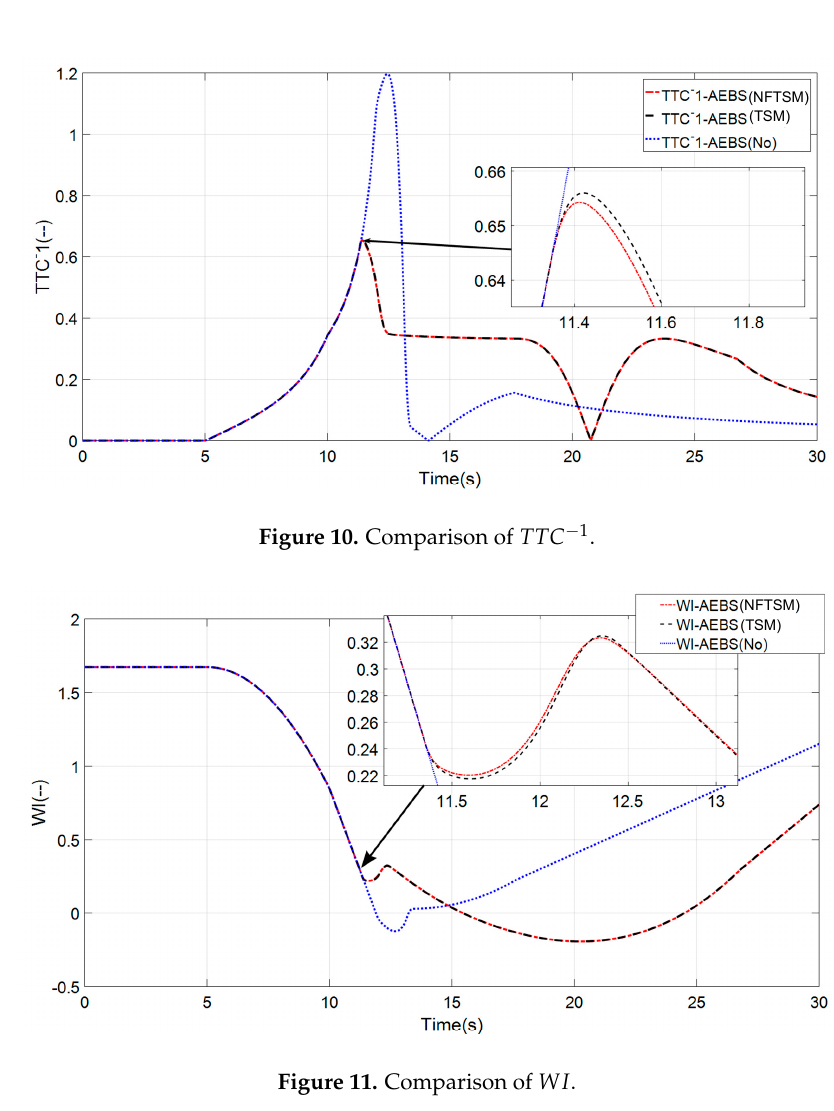
Figure 11. Comparison of WI .